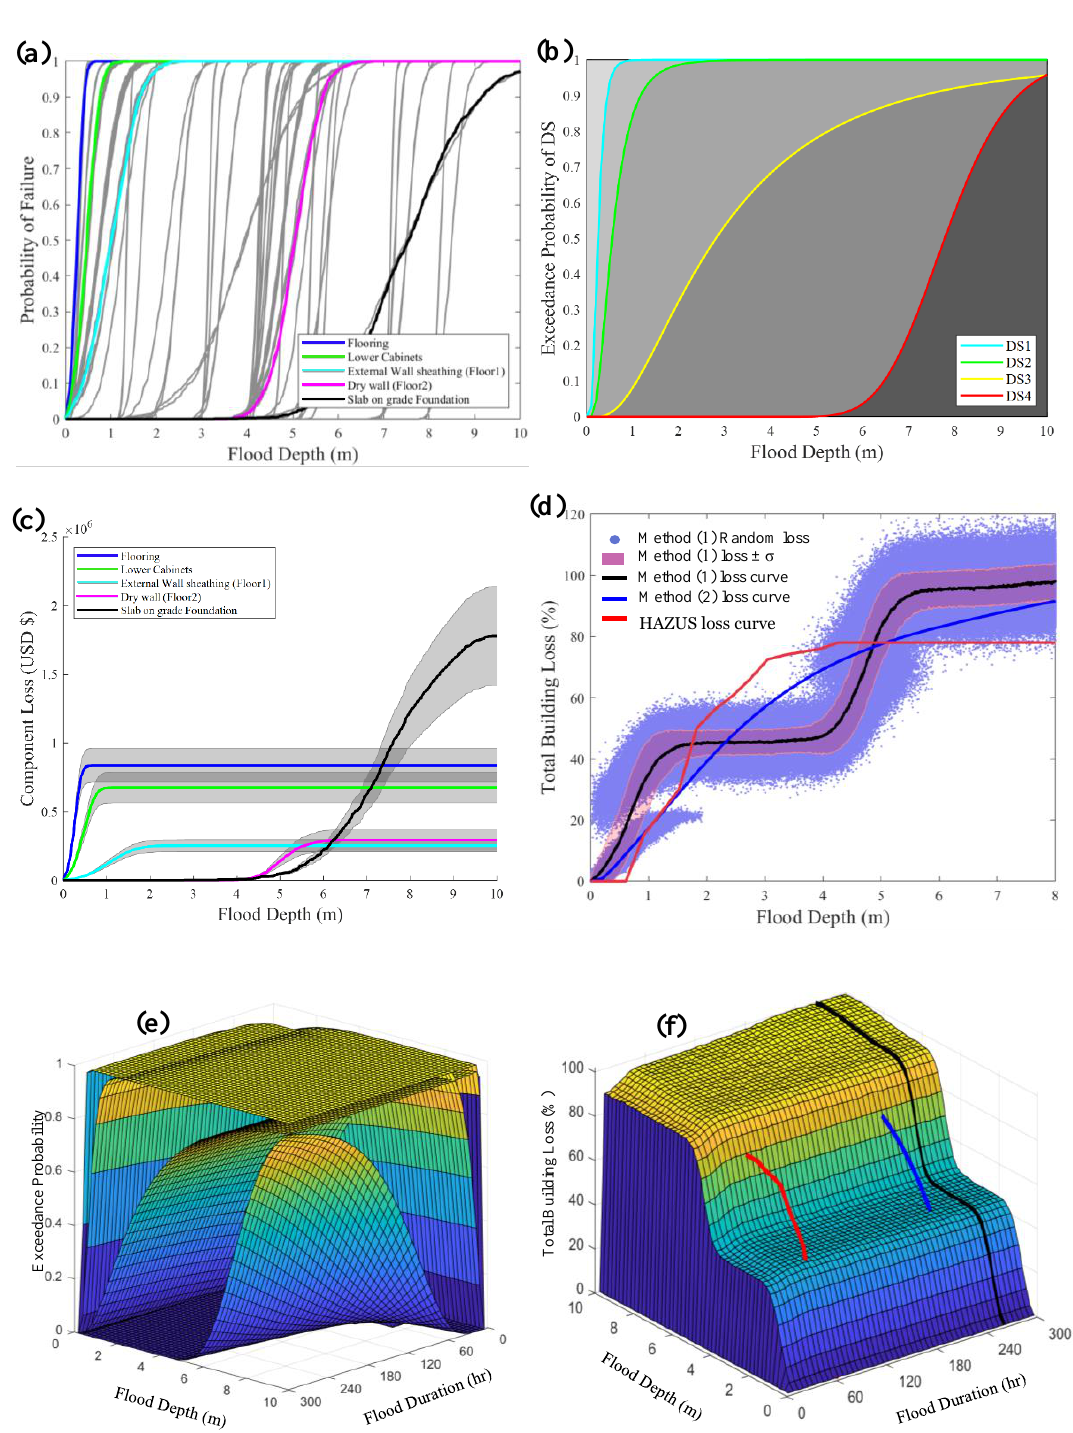
Figure A26. F12 archetype analysis results: ( a ) Component fragility curves; ( b ) Building fragility curves; ( c ) Selected components’ loss curves; ( d ) Building loss curves; ( e ) Building fragility surfaces; ( f ) Building loss surface.